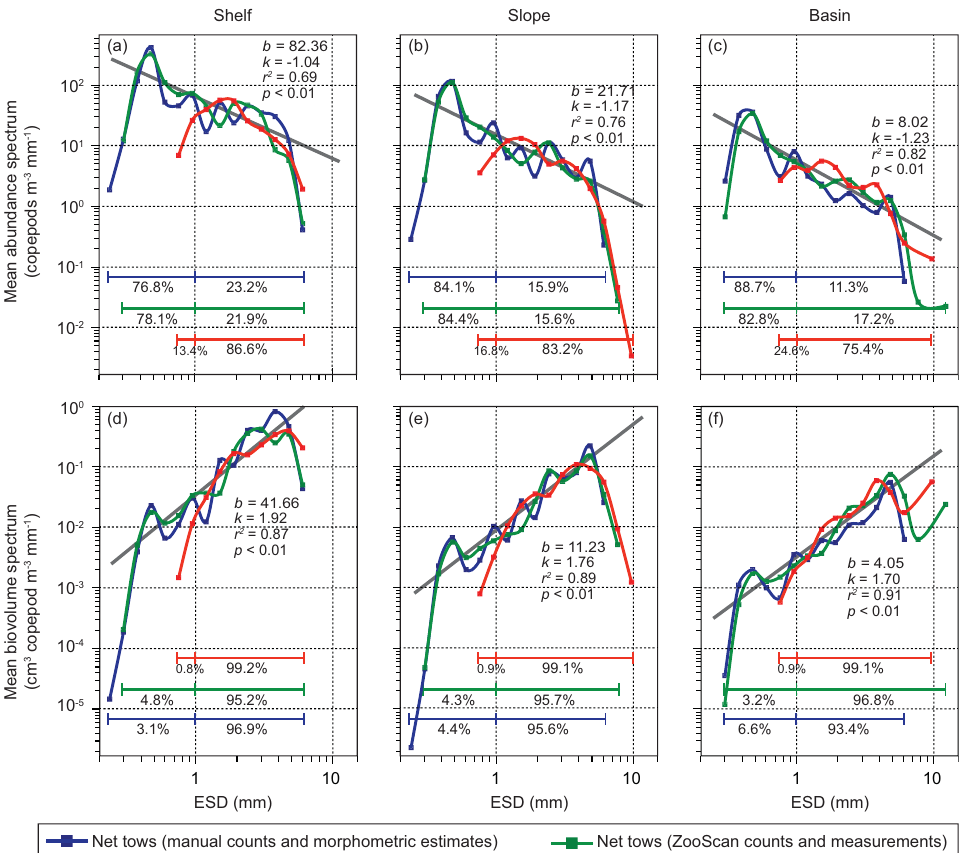
Fig. 9. Average size spectra of abundance (a–c) and biovolume (d–f) of the total copepod assemblage as estimated using traditional zoo- plankton nets (further divided into manual estimates and ZooScan measurements) and Underwater Vision Profiler deployments conducted at each of the overlapping stations (Fig. 1, Appendix A) across the shelf ( < 100m), slope (100–1000m), and basin ( > 1000m) regions of southeast Beaufort Sea in July–August 2009. The parameters of the power-law equations ( n = bd k ) derived from size distributions were calculated with the combined datasets (see Sect. 2.3 for details). In each panel, the percent contribution of copepods < 1mm and > 1mm to total abundance or biovolume (i.e. sum of all size-classes) is also given according to each methodology. ESD: equivalent spherical